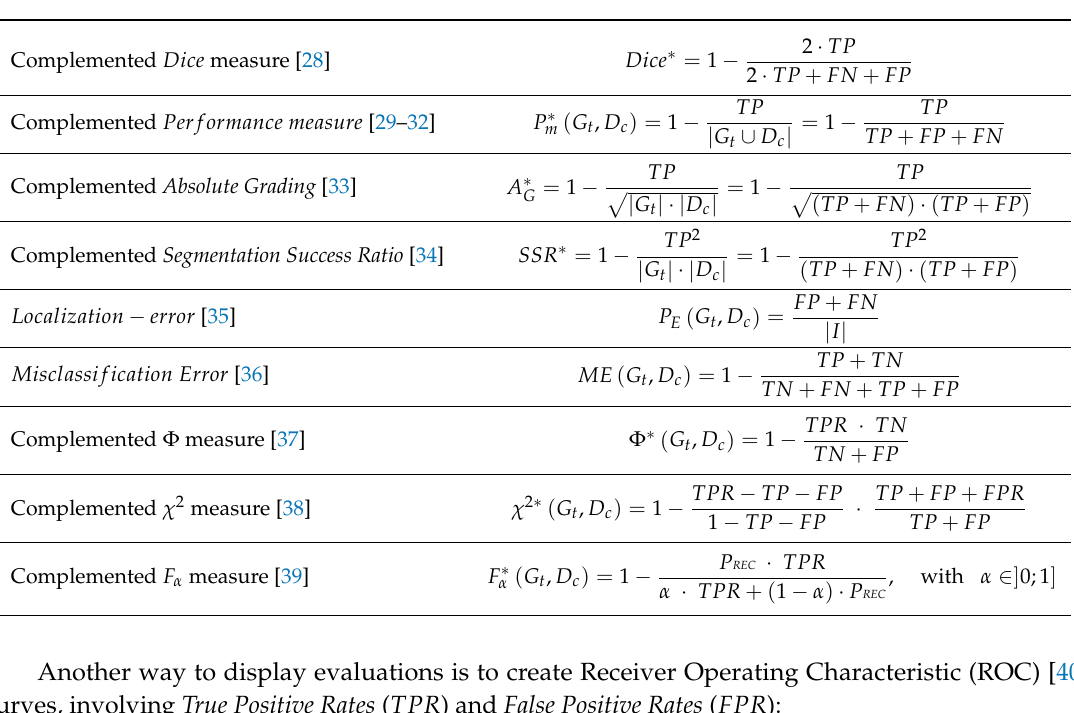
Table 2. List of error measures involving only